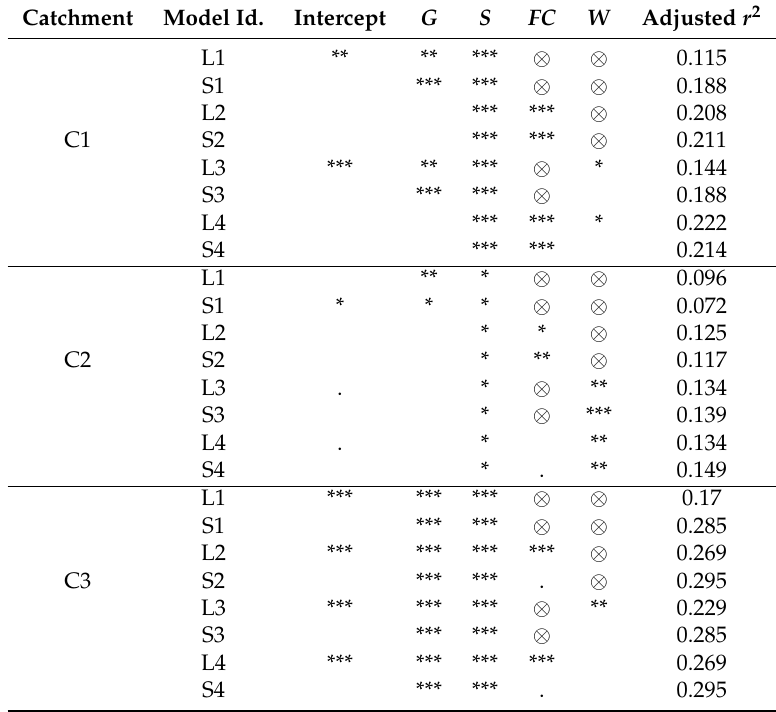
Table 3. Significance level of explanatory variables and adjusted r 2 of GAMM models. Model